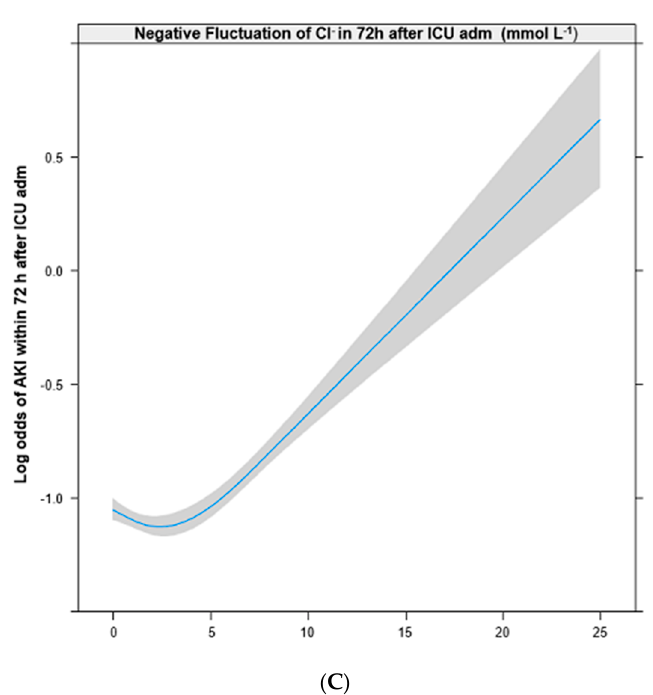
Figure 2. Restricted cubic spline between total ( A ), positive ( B ), and negative ( C ) fluctuations in serum chloride within 72 h after ICU admission and occurrence of AKI. ICU, intensive care unit; AKI, acute kidney injury. RRT, renal replacement therapy.